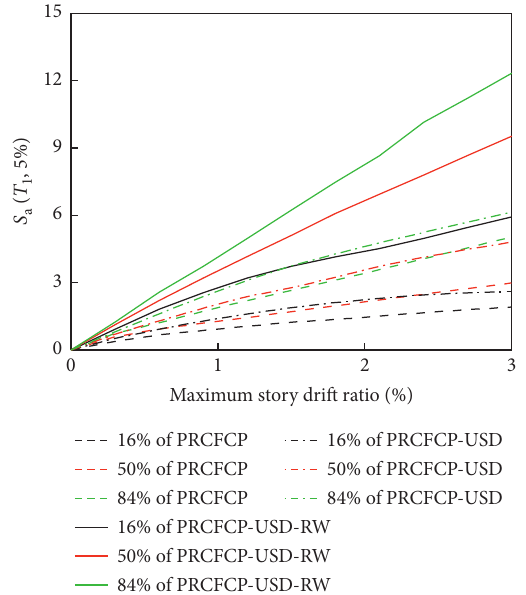
Figure 17: Comparison of the three models’ IDA